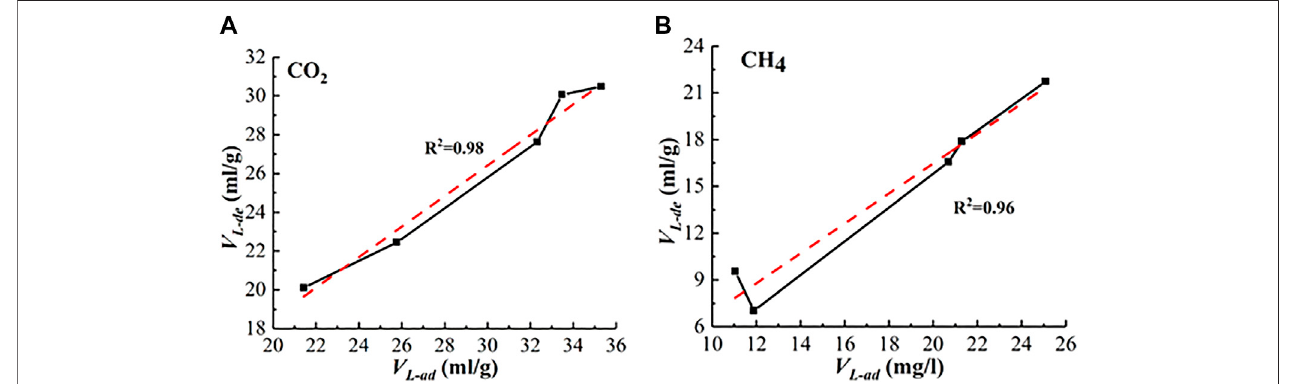
FIGURE 5 | Relationship between V L-ad and V L-de . (A) CO 2 , and (B) CH 4